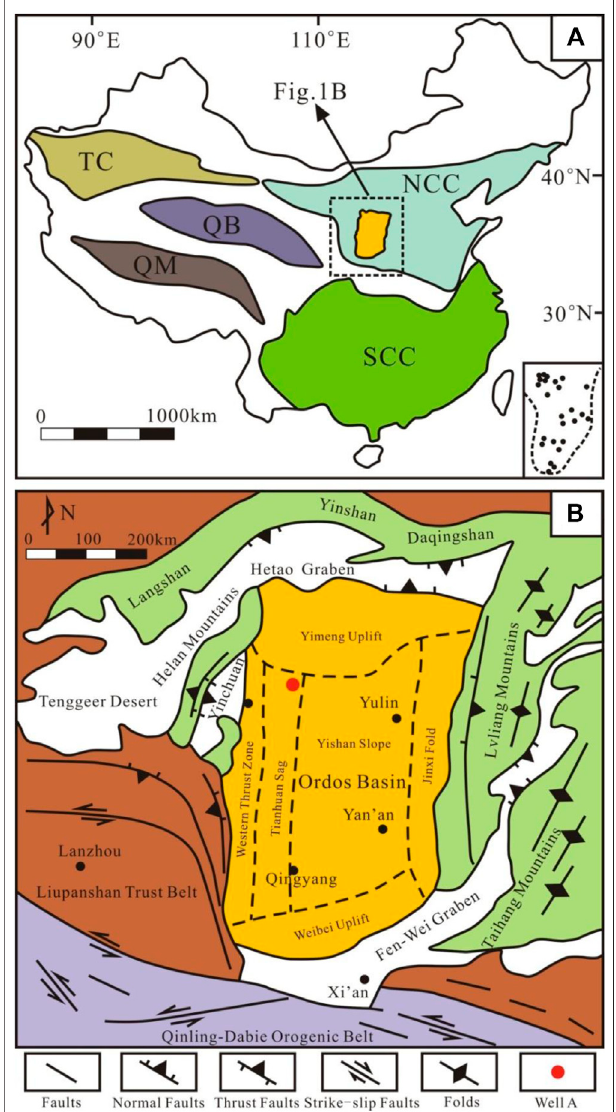
FIGURE1|(A) MajortectonicplatesinChina.NCC:NorthChinaCraton, SCC: South China Craton, TC: Tarim Craton, QB: Qaidam Block, and QM: Qiangtang Massif. (B) Simpli fi ed structural map of the Ordos Basin and its adjacent areas. Modi fi ed from Ritts et al.